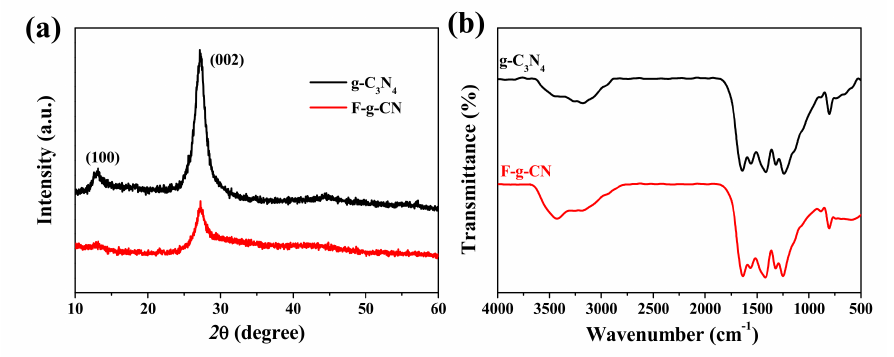
Figure 3. ( a ) XRD patterns and ( b ) FTIR spectra of g-C 3 N 4 and F-g-CN. The XPS measurement was carried out to investigate the chemical states and composi- tions of g-C 3 N 4 and F-g-CN. The XPS survey spectrum of F-g-CN directly